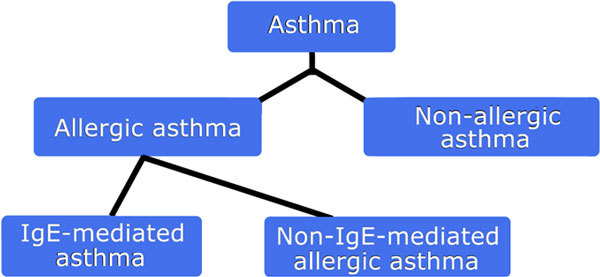
The nomenclature of asthma [34,35].